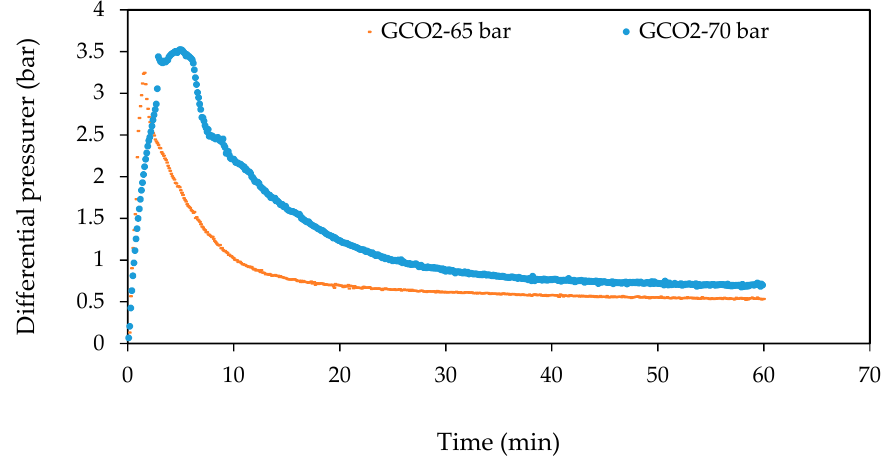
Figure 3. Effect of fluid pressure on the differential pressure profile of low-pressure GCO 2 –oil displacements conducted at 0.4 mL/min and 33 °C.